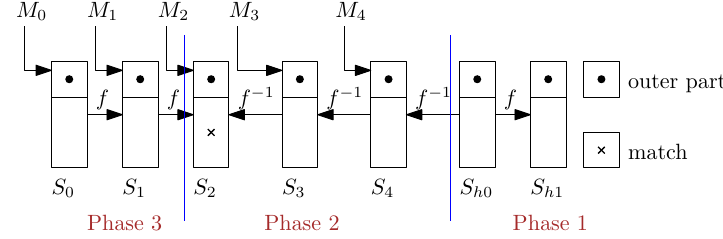
Figure 6: Framework of the generic preimage